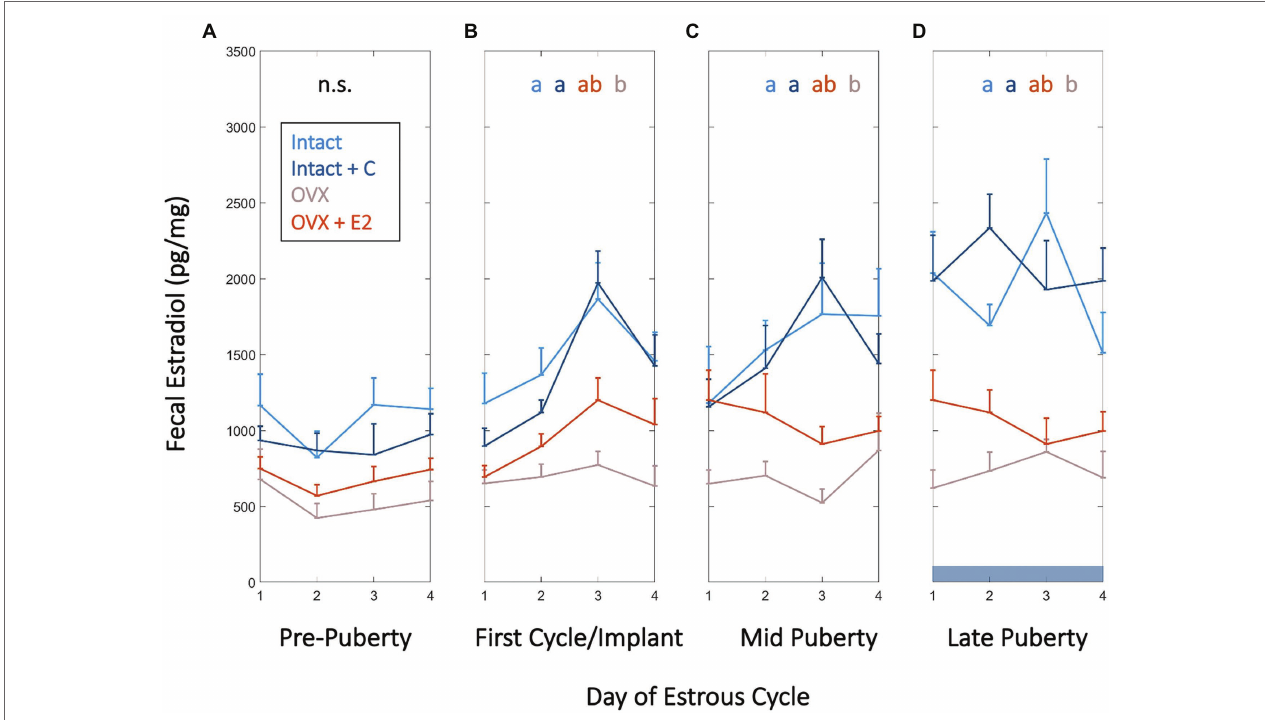
FIGURE 1 | High frequency fecal estradiol (fE2) enables monitoring of estrous cycle emergence, sex steroid manipulation, and ovarian status during adolescence. Group mean (+SEM) fE2 concentrations of Intact (light blue), Intact + short-term pubertal contraceptives (Intact + C; dark blue), Ovariectomized (OVX; gray), and OVX + E2 (orange) groups did not significantly differ prior to puberty (p24–p30; A ). Fecal estradiol in Intact and Intact + C groups increased over that of OVX animals beginning at the first cycle following vaginal opening or relative to the time of silastic implant in OVX + E2 animals (p30–p37; B ) and remained significantly elevated thereafter at mid puberty (p43–p49; C ) and during late puberty (p55–p61; D ). Dark horizontal bar in D indicates Intact + C data were gathered during contraceptive administration. Color of letters at the top of B , C , and D indicate experimental group; letters indicate statistical differences, with groups not sharing the same letter being significantly different ( p <